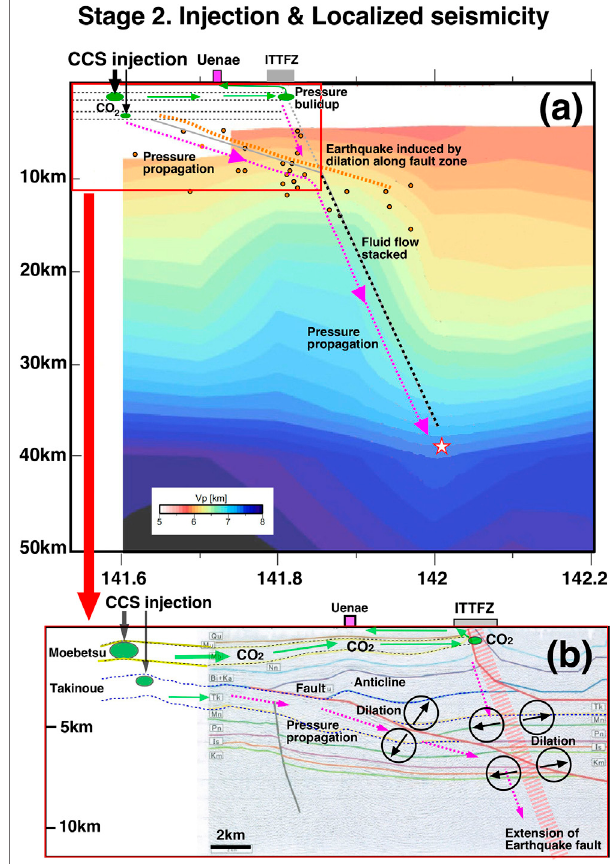
FIGURE 4 | Schematic vertical cross-section of the Hokkaido Iburi region along the H91-3 seismic pro fi le of Figure 1 , and its extension southwest and northeast in two years after CCS-CO 2 injection and immediately before the M6.7 earthquake (A) P-wave velocity (Vp) structure of the crust and upper mantle in the region. The red dotted arrows and gray thin line show possible pressure propagation and a pre-existing fault in the region, respectively. The orange dotted curve denotes a fault found by seismic re fl ection survey. Orange dots are possibly induced earthquakes by dilation along fault zone. (B) Modi fi ed subsurface structure of the seismic section along H91-3 in Figure 1 reported by Yokokura et al. (2014). Red square of top fi gure is enlarged here. The green solid arrows and red dotted arrows show movement of CO 2 fl uid and direction of pressure propagation, respectively. Arrows in circles indicate the dilation due to pore pressure.